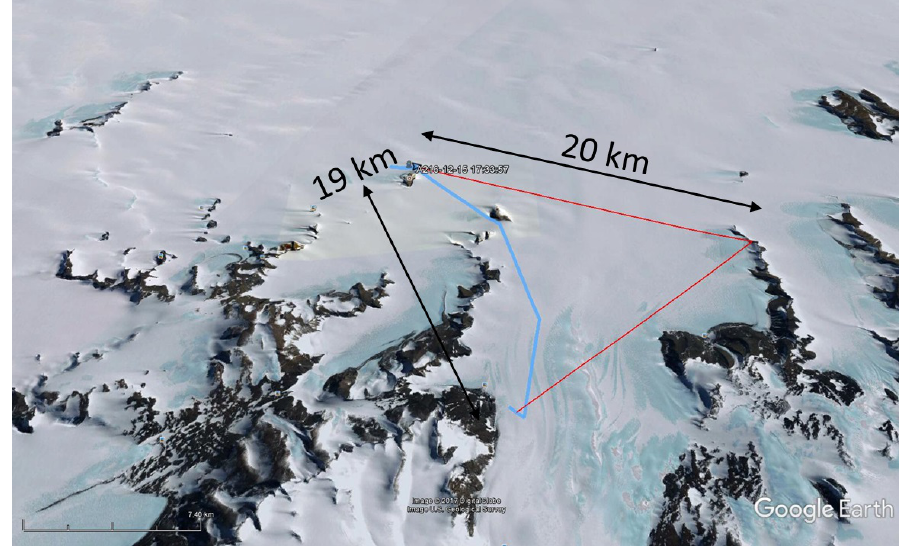
Figure 16. Possible reflection